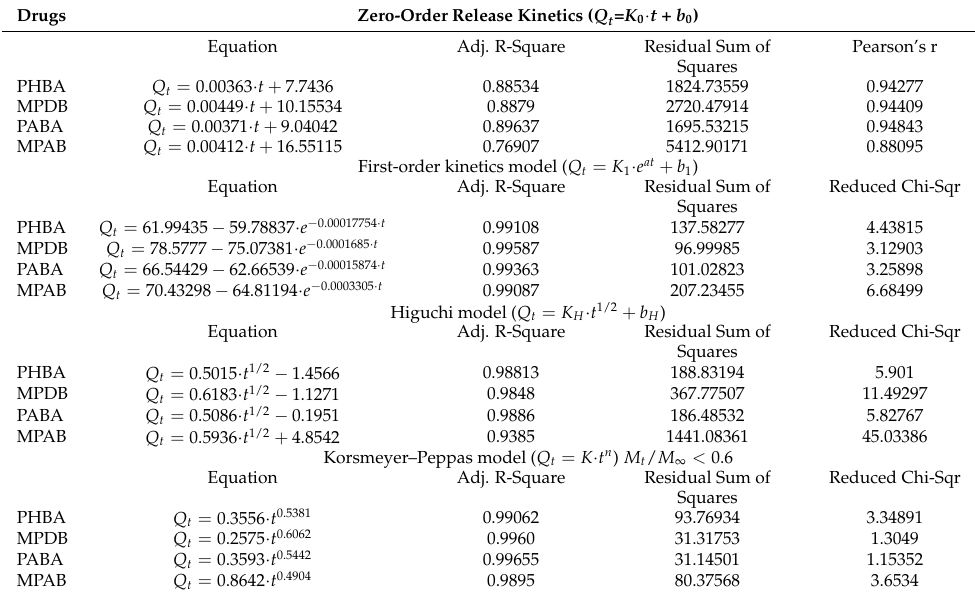
Table 1. The release kinetics model fitting parameters of PHBA, MPDB, PABA, and MPAB